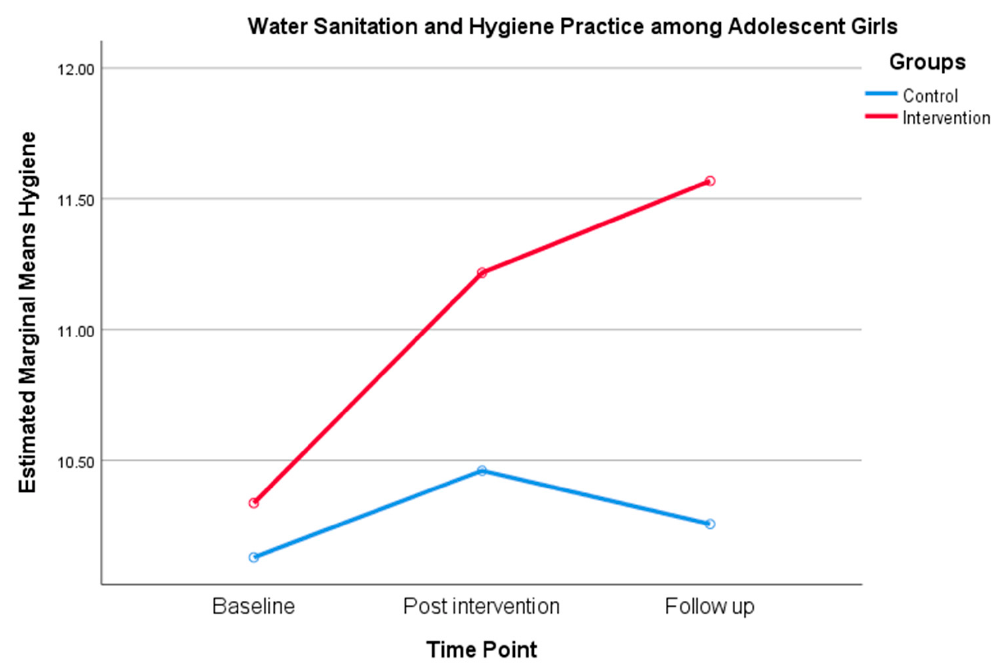
Figure 1. Changes in WASH practice between intervention and control group at three time points.